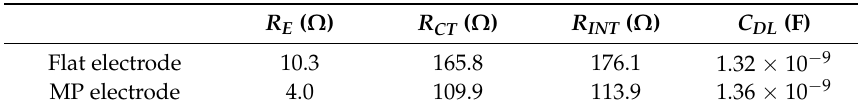
Table 1. Electrolyte resistance ( R E ), charge transfer resistance ( R CT ), internal resistance ( R INT ) and double layer capacitance ( C DL ) of flat and MP electrodes without